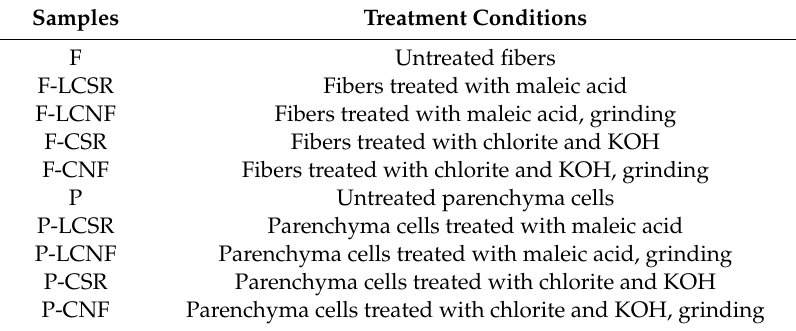
Table 1. Abbreviations of the products obtained at each stage of sample